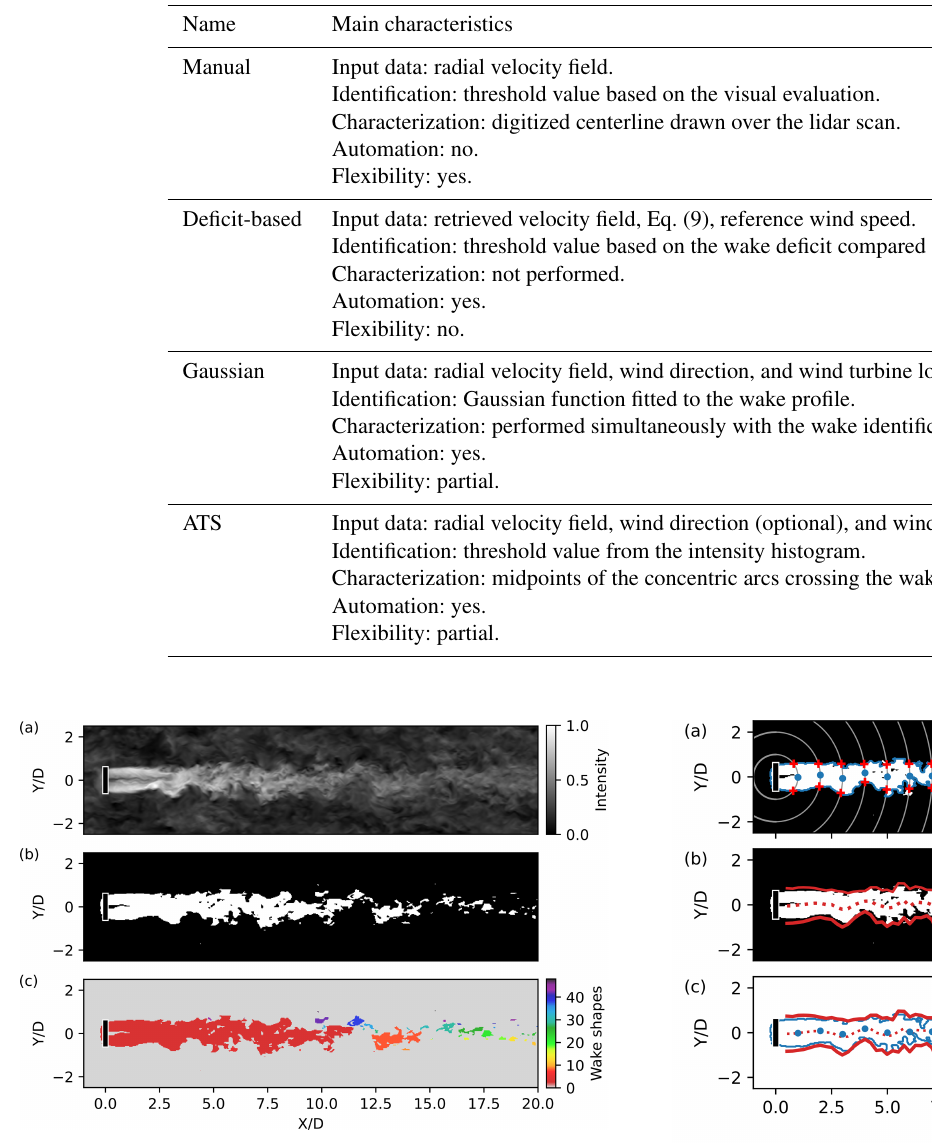
Figure 12. Wake and centerline identification for a sample instan- taneous LES wake: (a) normalized flow field, same as Fig. 9b; (b) thresholded flow field; and (c) wake shapes color-coded to show connectivity.